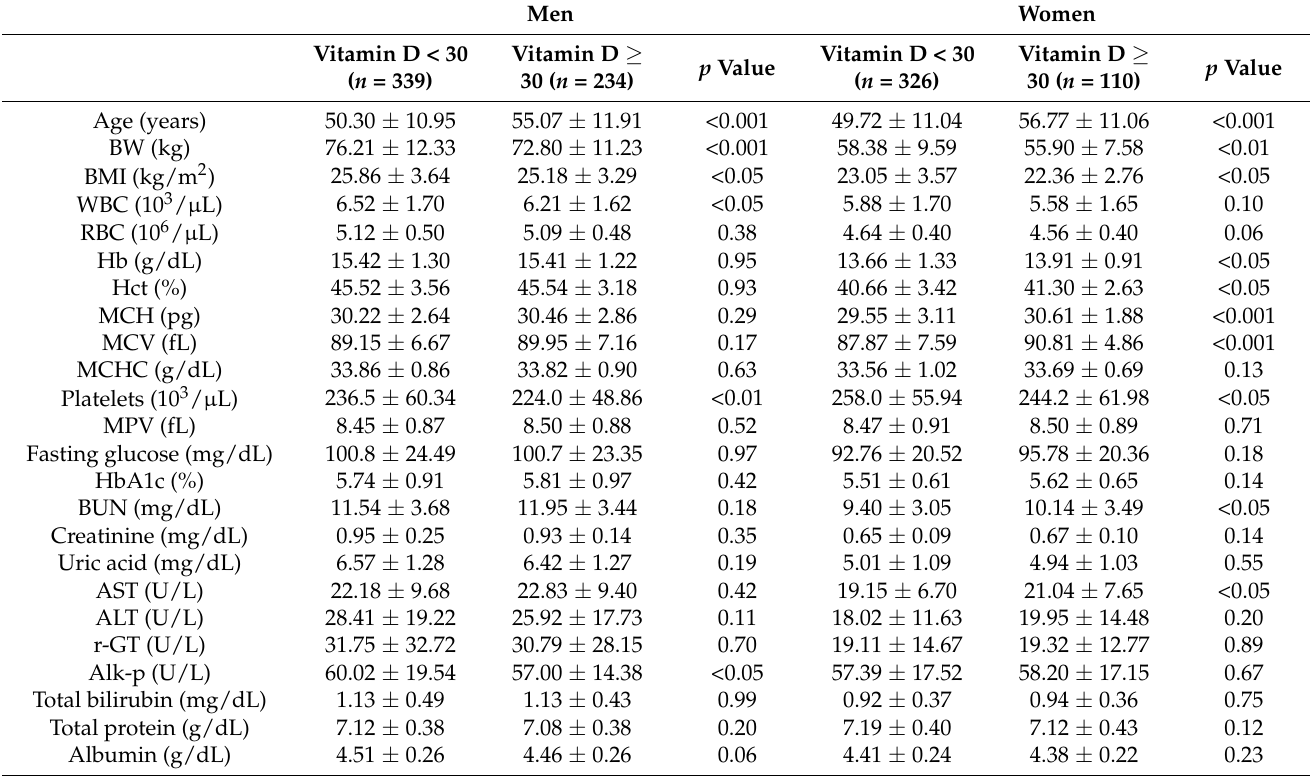
Table 2. Associations between vitamin D status and biomarkers in men and